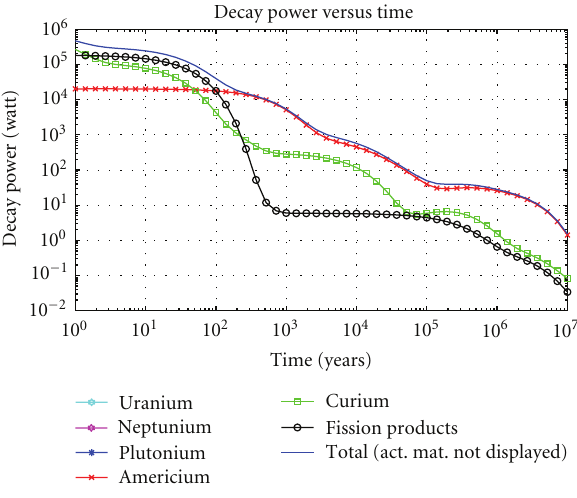
Figure 30: Contributions to heatload versus time—GCFR SNF end fifth